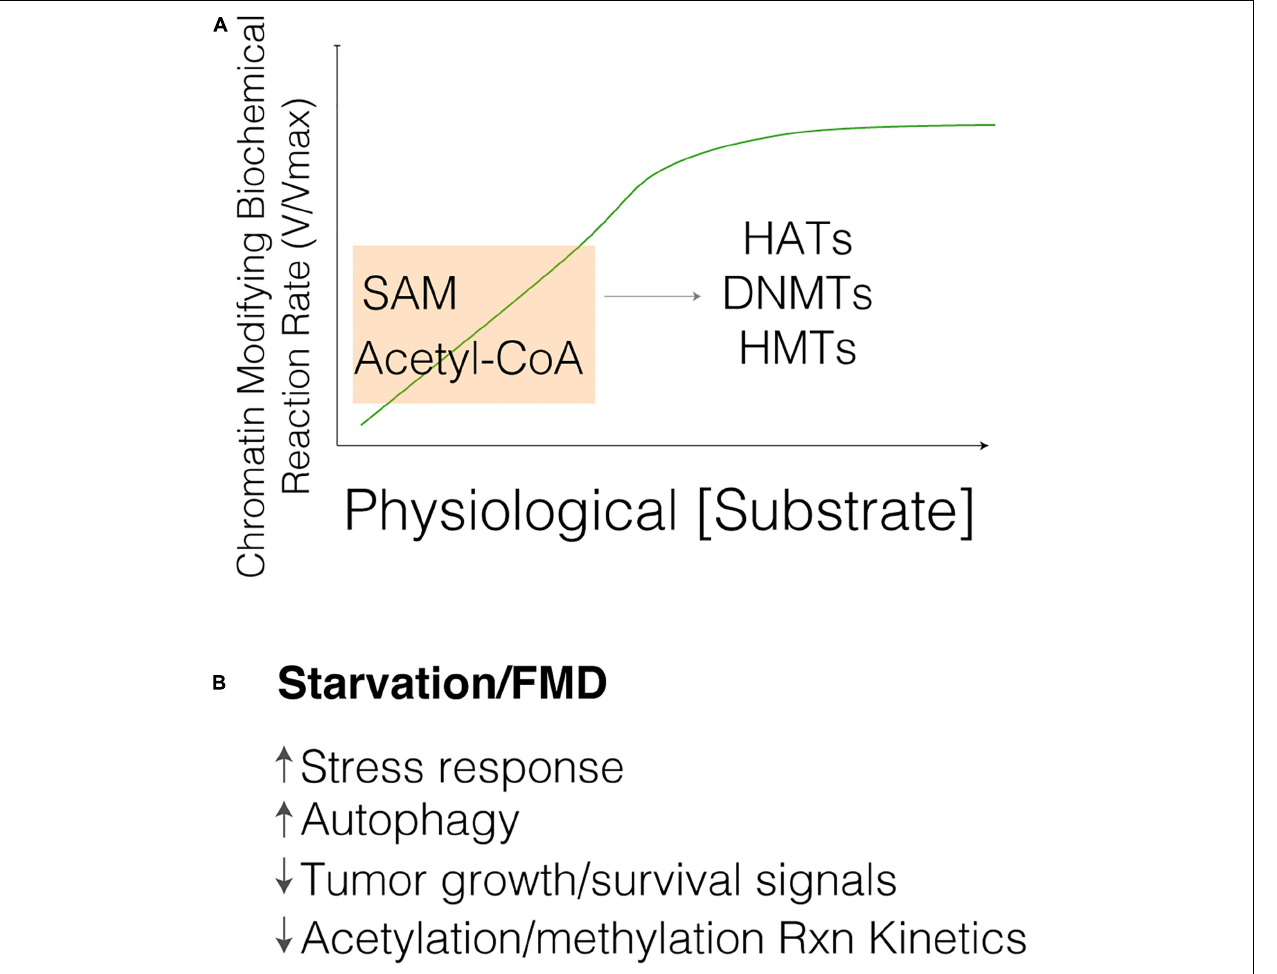
FIGURE 4 | Physiological concentrations of Acetyl-CoA and SAM are rate limiting for HATs, DNMTs, and HMTs and affect chromatin modifications. (A) Dietary changes that limit cellular SAM and Acetyl-CoA substrate concentrations are expected to reduce biochemical reactions mediating chromatin acetylation and methylation dynamics because these substrates lie within concentrations that are enzymatically rate limiting. (B) The hypothesized benefits of starvation periods or fasting-mimicking diets (FMD) are summarized and could include decreased acetylation and methylation reaction kinetics that help impair tumor cell diversity and